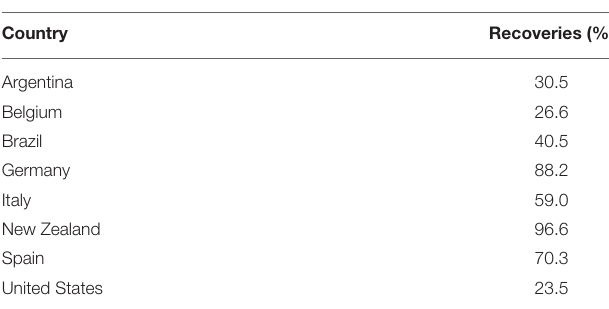
TABLE 1 | Recoveries (May 21,